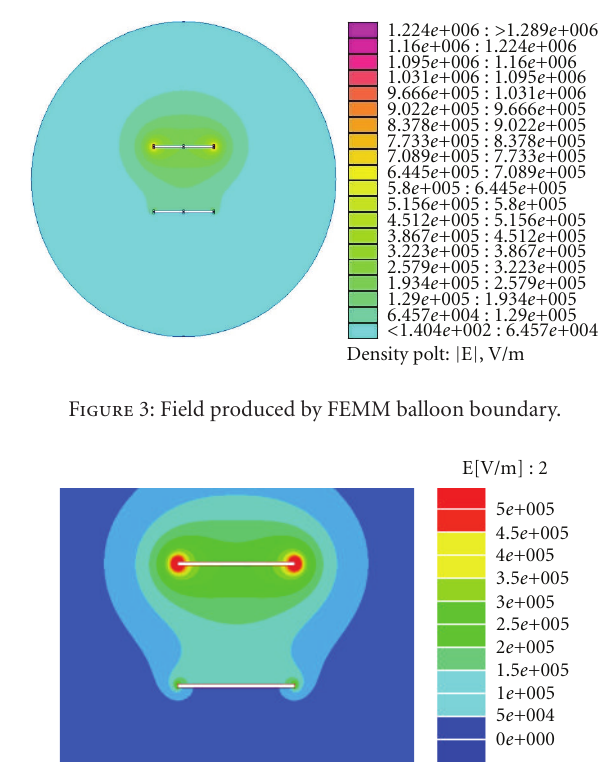
Figure 4: Field produced by Maxwell with a balloon